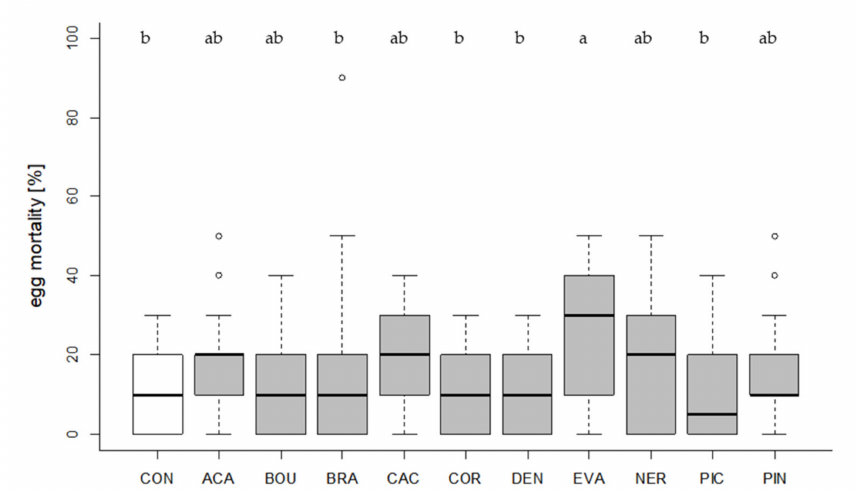
Figure 3. Percentage of aborted ( = yellow colored, unhatched) T. absoluta eggs. Egg mortality of the control condition (CON, white, no Trichogramma exposure) and egg mortality depending on the tested Trichogramma strains (30 parasitizing females per strain provided with 10 eggs) are shown. Box plots denote median (solid line), whiskers show range of data, and circles represent outliers. Di ff erent letters indicate significant di ff erences between groups ( p <